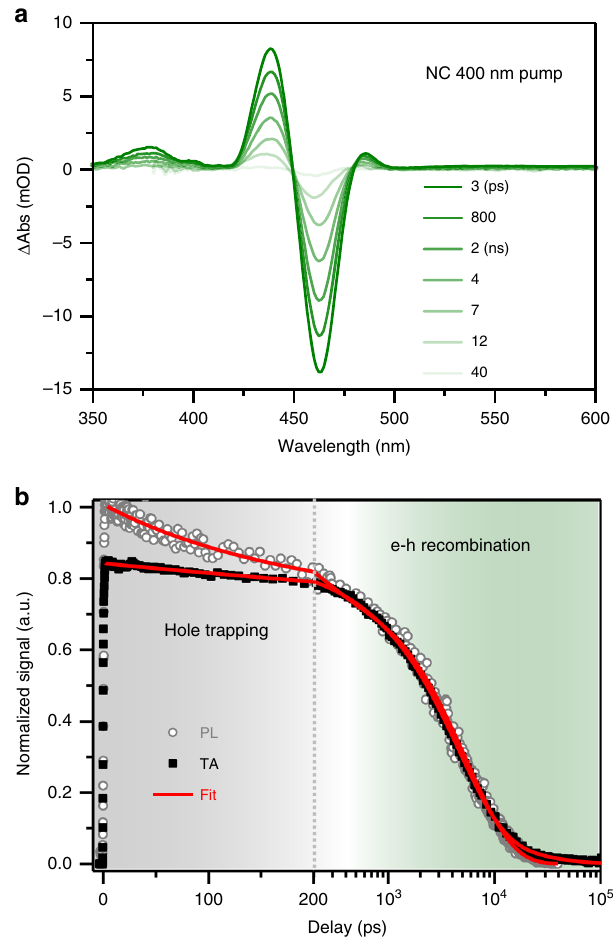
Fig. 4 Exciton dynamics in free NCs. a TA spectra of CsPbBr 3 NCs at indicated time delays following the excitation by a 400nm pulse. b TA kinetics of NCs probed at the XB centre (~460 nm; black solid squares) and TR-PL kinetics probed at the PL peak (~475nm; grey open circles). The red solid lines are their fi ts using a model accounting for a minor hole trapping component and a major electron-hole recombination component. Note that the fi rst 200 ps is plotted in linear scale and the rest in logarithmic